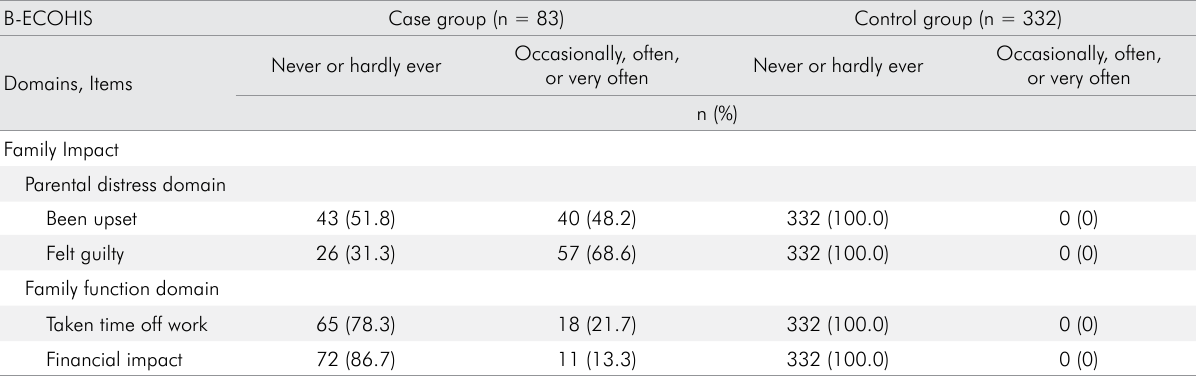
Table 1. Distribution of responses to Brazilian version of Early Childhood Oral Health Impact Scale (B-ECOHIS) among preschool children in the case and control